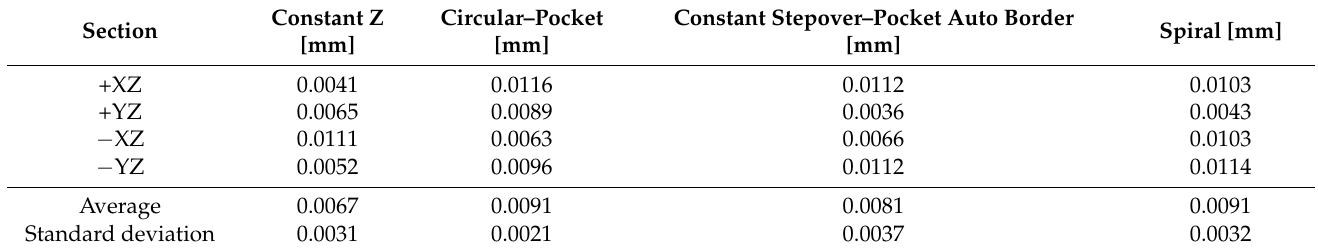
Table 5. Measured straightness deviations.